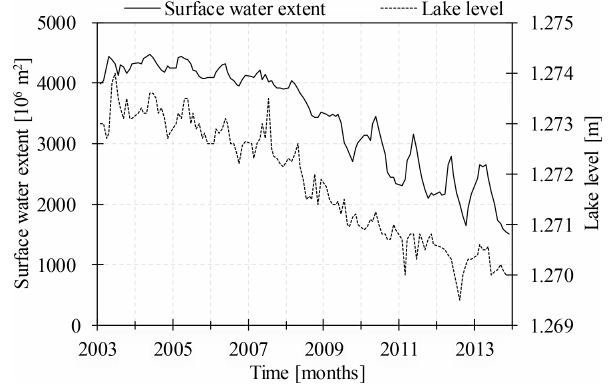
Figure 2. Time series of surface water extent and water level eleva- tion of Lake Urmia (data from Tourian et al.,